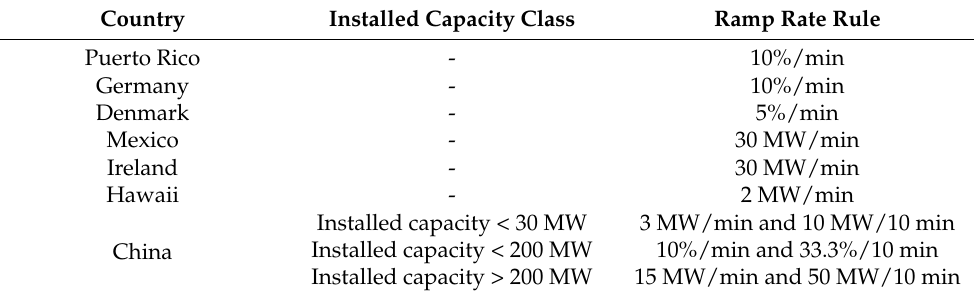
Table 1. Ramp rate limit of different national grid